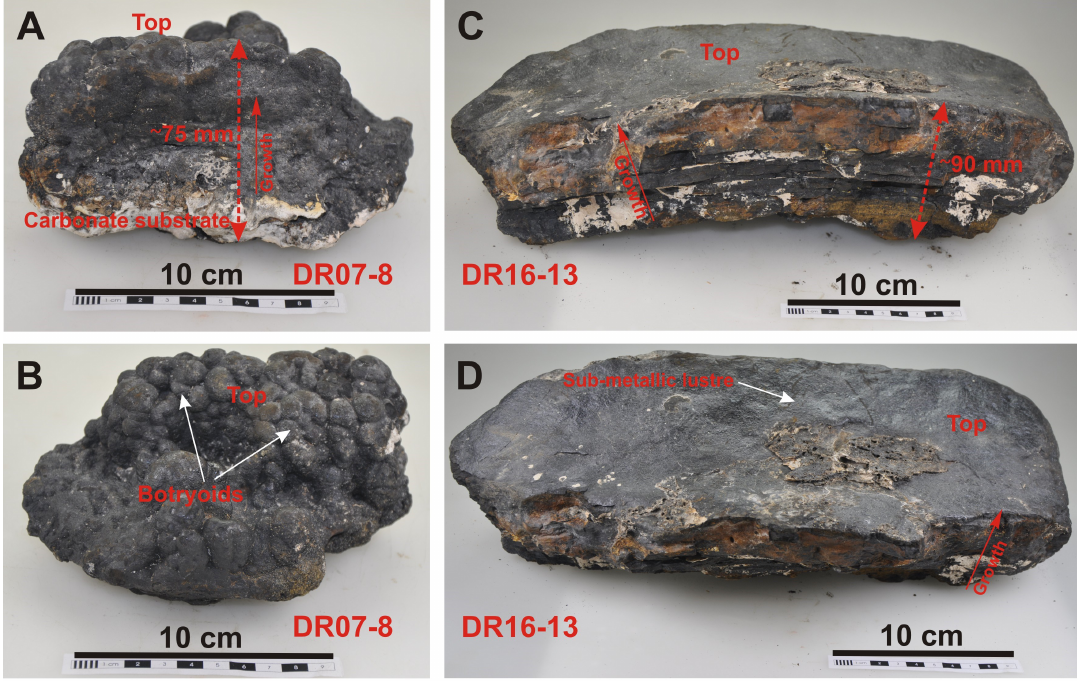
Figure 2. Images of the selected Fe–Mn crusts. ( A , B ) Frontal and upper view of DR07-8 collected from The Paps Seamount and ( C , D ) of DR16-13 collected from the Tropic Seamount. Both crusts show a different morphology; crust DR07-8 is mainly botryoidal while crust DR16-13 shows a more planar